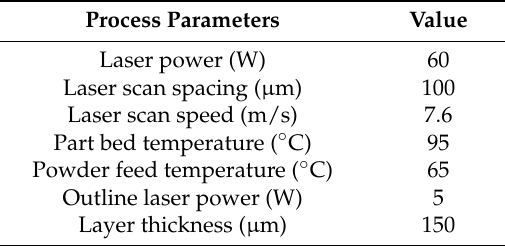
Table 1. Sintering parameters adopted for processing thermoplastic polyurethane/graphene (TPU/GE) composite